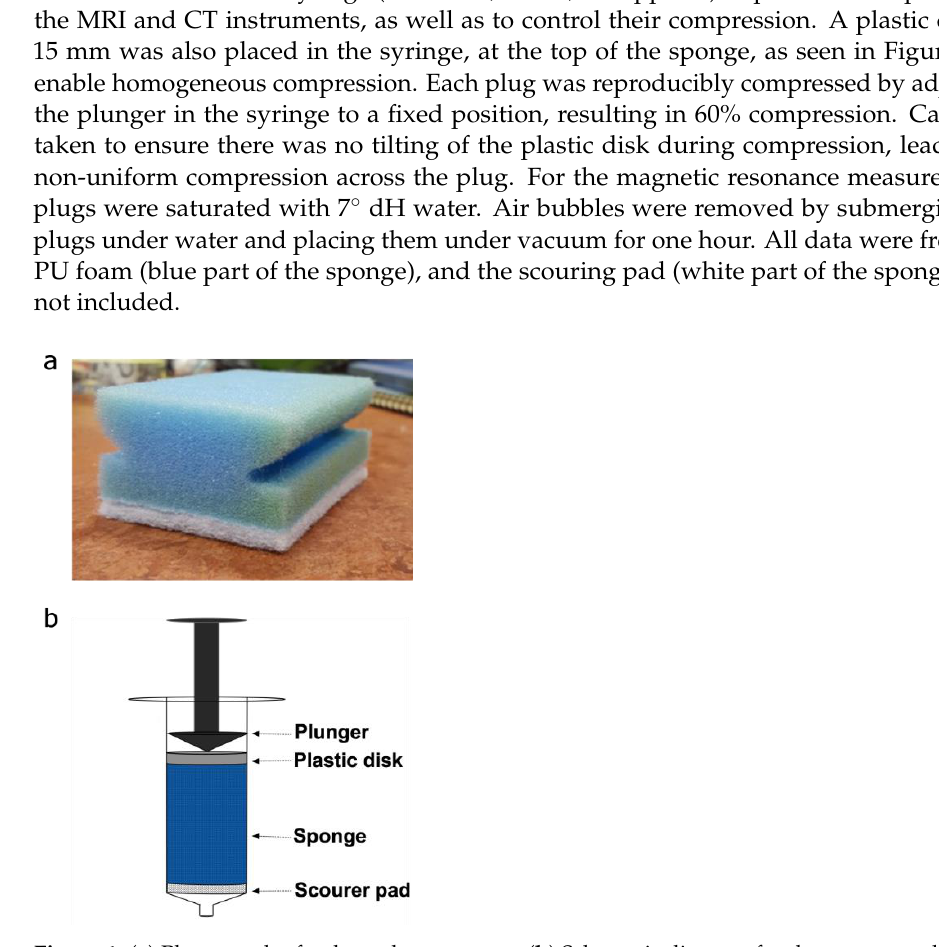
Figure 1. ( a ) Photograph of polyurethane sponge. ( b ) Schematic diagram for the set-up used to hold and compress sponge